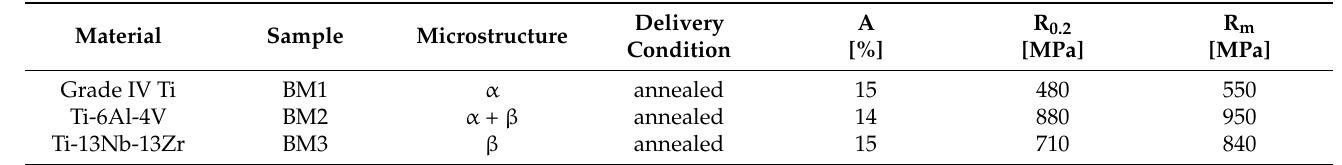
Table 1. Selected mechanical properties of grade IV Ti, Ti-6Al-4V and Ti-13Nb-13Zr samples (based on the manufacturers’ certificates).